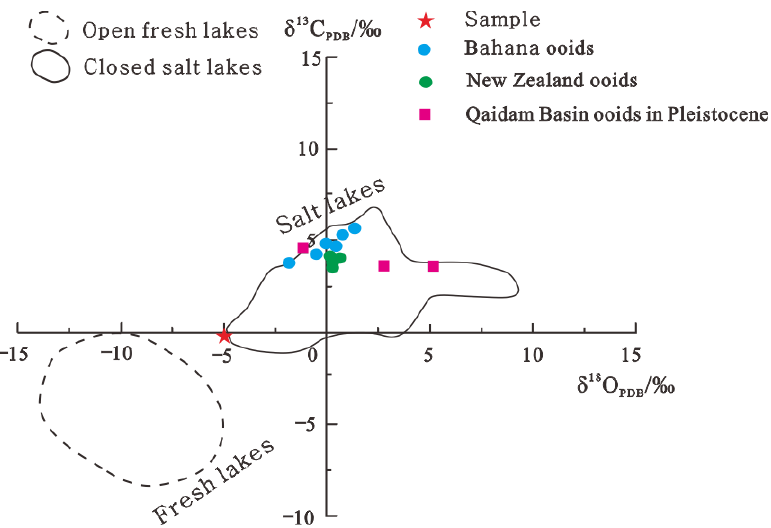
Figure 9. Scatter plot of carbon versus oxygen isotopic compositions of ooids (modified from Sun et al. [24]). Carbon and oxygen isotopic data of the Bahamas ooids, the New Zealand ooids and the Pleistocene ooids in the Qaidam Basin are from Rankey et al. [64], Duguid et al. [63] and Sun et al. [24], respectively.